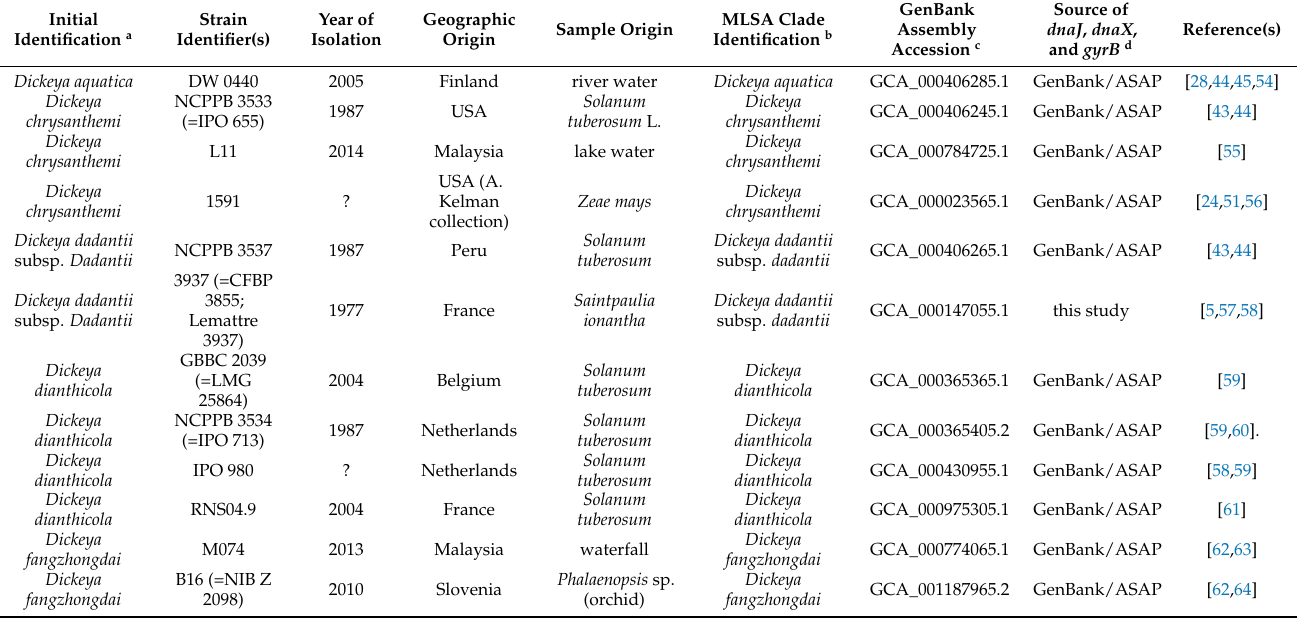
Table 3. Description of reference strains of Dickeya and Pectobacterium and MLSA clades predicted by dnaJ, dnaX , and gyrB multilocus sequence